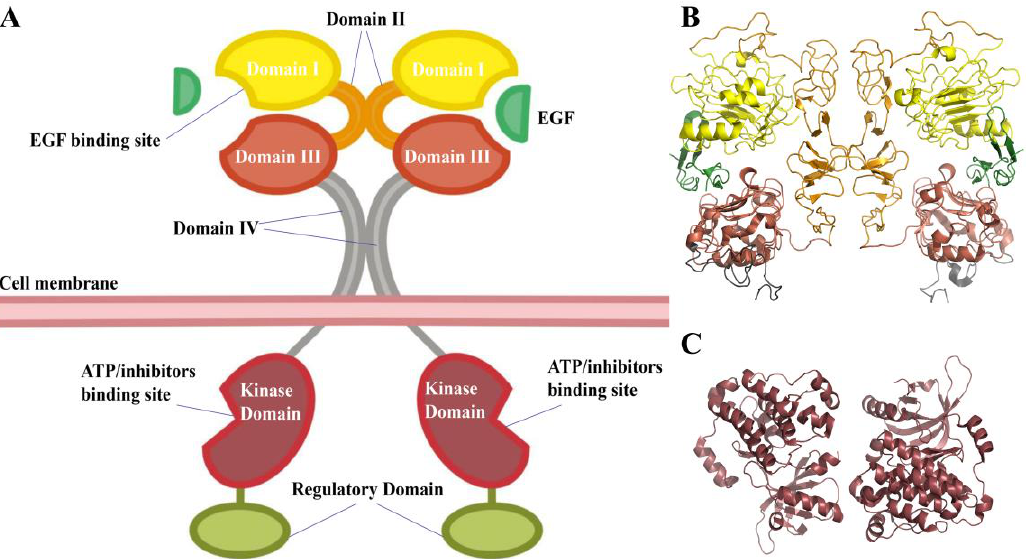
Figure 1. ( A ) Schematic of EGFR dimer. Domain I (yellow) and domain III (pink) are EGF binding regions. Domain II (orange) and domain IV (grey) are regions responsible for dimerization. ( B ) The three-dimensional extracellular region structure of EGFR (PDB ID: 1NQL). ( C ) The structure of intracellular tyrosine kinase domain (PDB ID: 2ITZ).